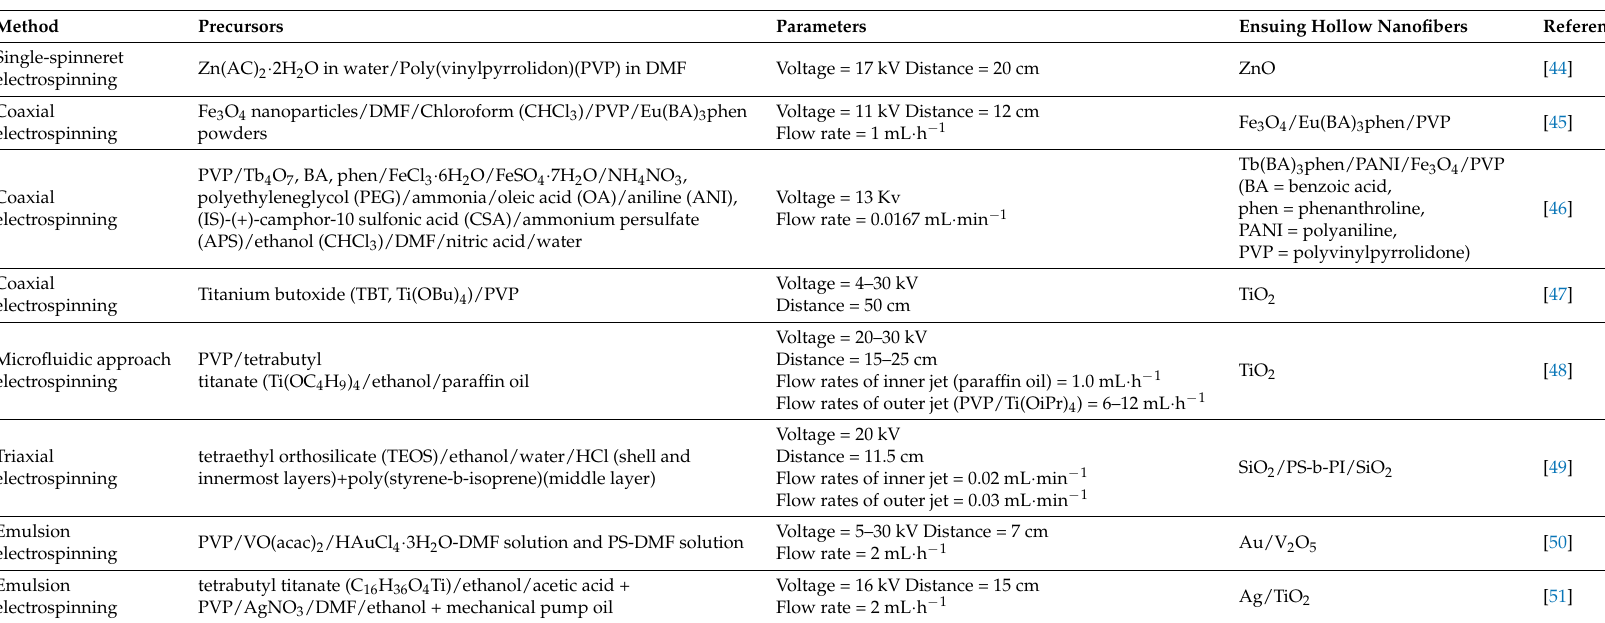
Table 1. Various electrospinning methods for the production of ceramic hollow nanofibers, examples, and detailed operational parameters (studies performed after 2010 were mainly